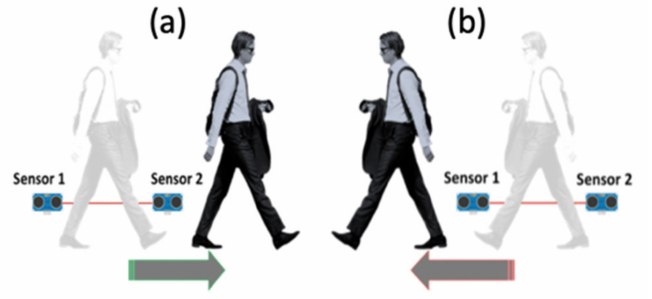
Figure 6. ( a ) The ultrasonic device detecting a “getting on” event; ( b ) the ultrasonic device detecting a “getting off”